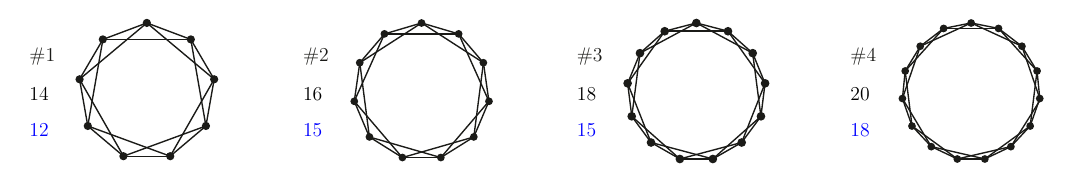
m= 2 inscribed in a circle for m = 9 ; 11 ; 13 ; 15. The f g